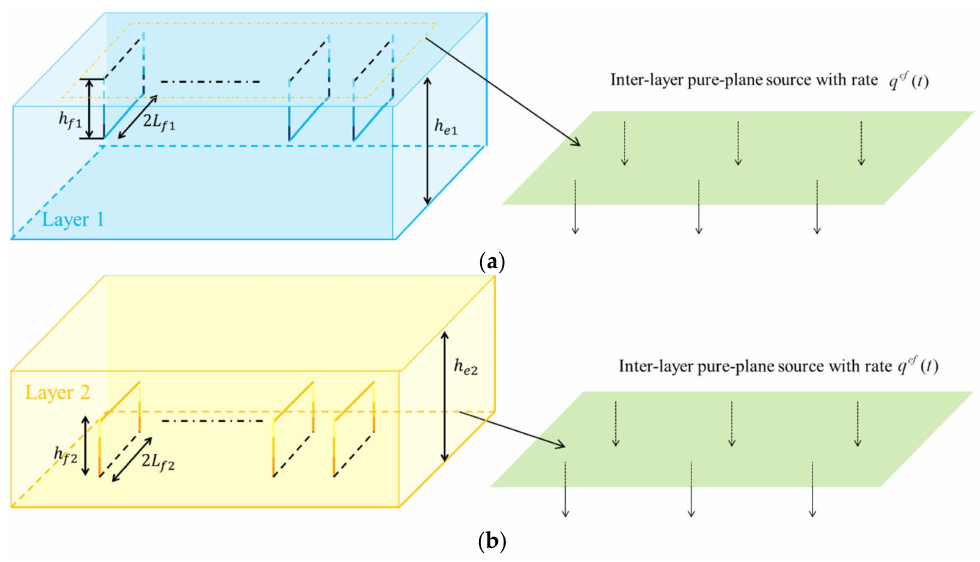
Figure 3. Reservoir ( a ) from the perspective of Layer 1 and ( b ) from the perspective of Layer 2. Accounting the inter-layer pure-planar crossflow fluid transfer rate between the two layers as q cf , the original reservoir system can then be decomposed into two homogeneous sub-reservoirs. Decomposing the reservoir components from one another at their junction is achieved by applying “no-flow boundary” concept. For simple reservoir systems that contain wells, the no-flow boundary is achieved by applying well-principled images. For the situation being considered, Layer 1 and Layer 2 are each individually modeled using this strategy, and the processes are graphically presented in Figure 4a,b. The decomposed Layer 1 and Layer 2 systems are subsequently coupled using pressure and rate continuity at their contact interface through the application of the pure-plane concept